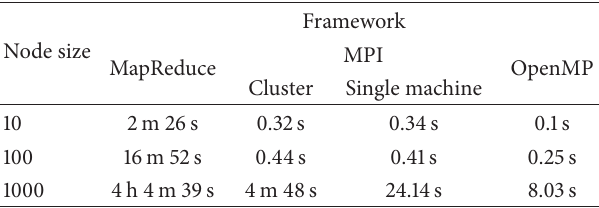
Table 1: Execution times for the all-pairs-shortest-path problem.